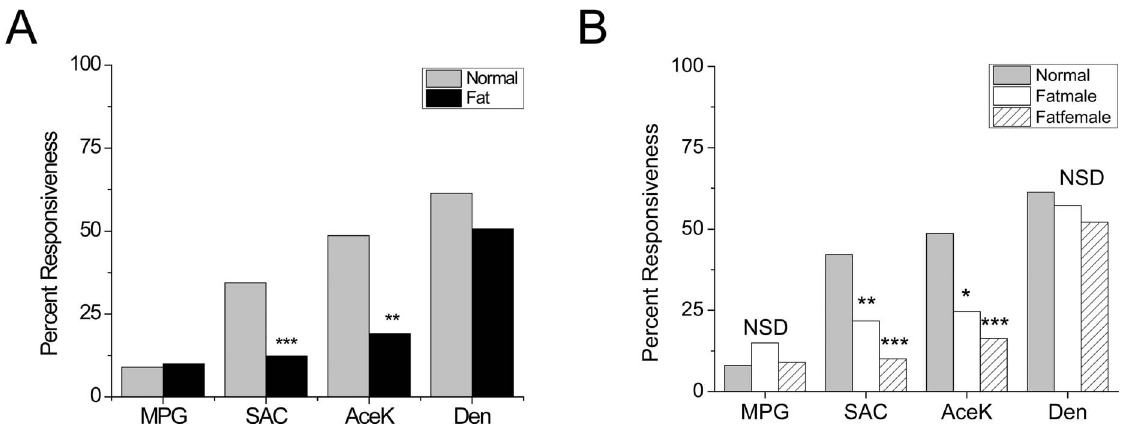
Figure 2. Fewer taste cells are sensitive to sweet taste stimuli in obese mice. Chi-square analysis was used to compare the percentage of responsive taste receptor cells between normal and obese mice. (A) Bar graphs represent the percentages of taste-evoked calcium responses to each taste stimuli. The number of responsive taste cells for the sweet stimuli (2 mM Sac, 20 mM AceK) were significantly reduced for the obese mice (black bar) compared to controls (gray bar) (***, p , 0.001; **, p , 0.01; *, p , 0.05). The numbers of taste-evoked calcium responses to the umami taste stimuli (20 mM MPG) and the aversive bitter stimuli (5 mM Den) were not significantly different between the two groups. (B) When obese mice were analyzed by sex, both males and females were significantly less responsive to the sweet taste stimuli tested compared to control mice (***, p , 0.001; **, p , 0.01; *, p , 0.05).